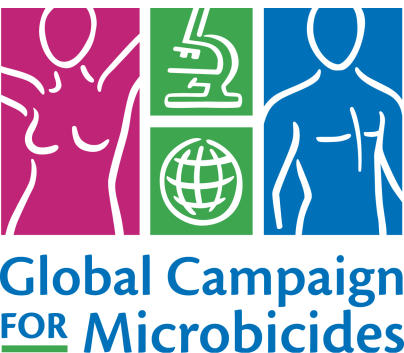
(Image: Global Campaign for Microbicides)